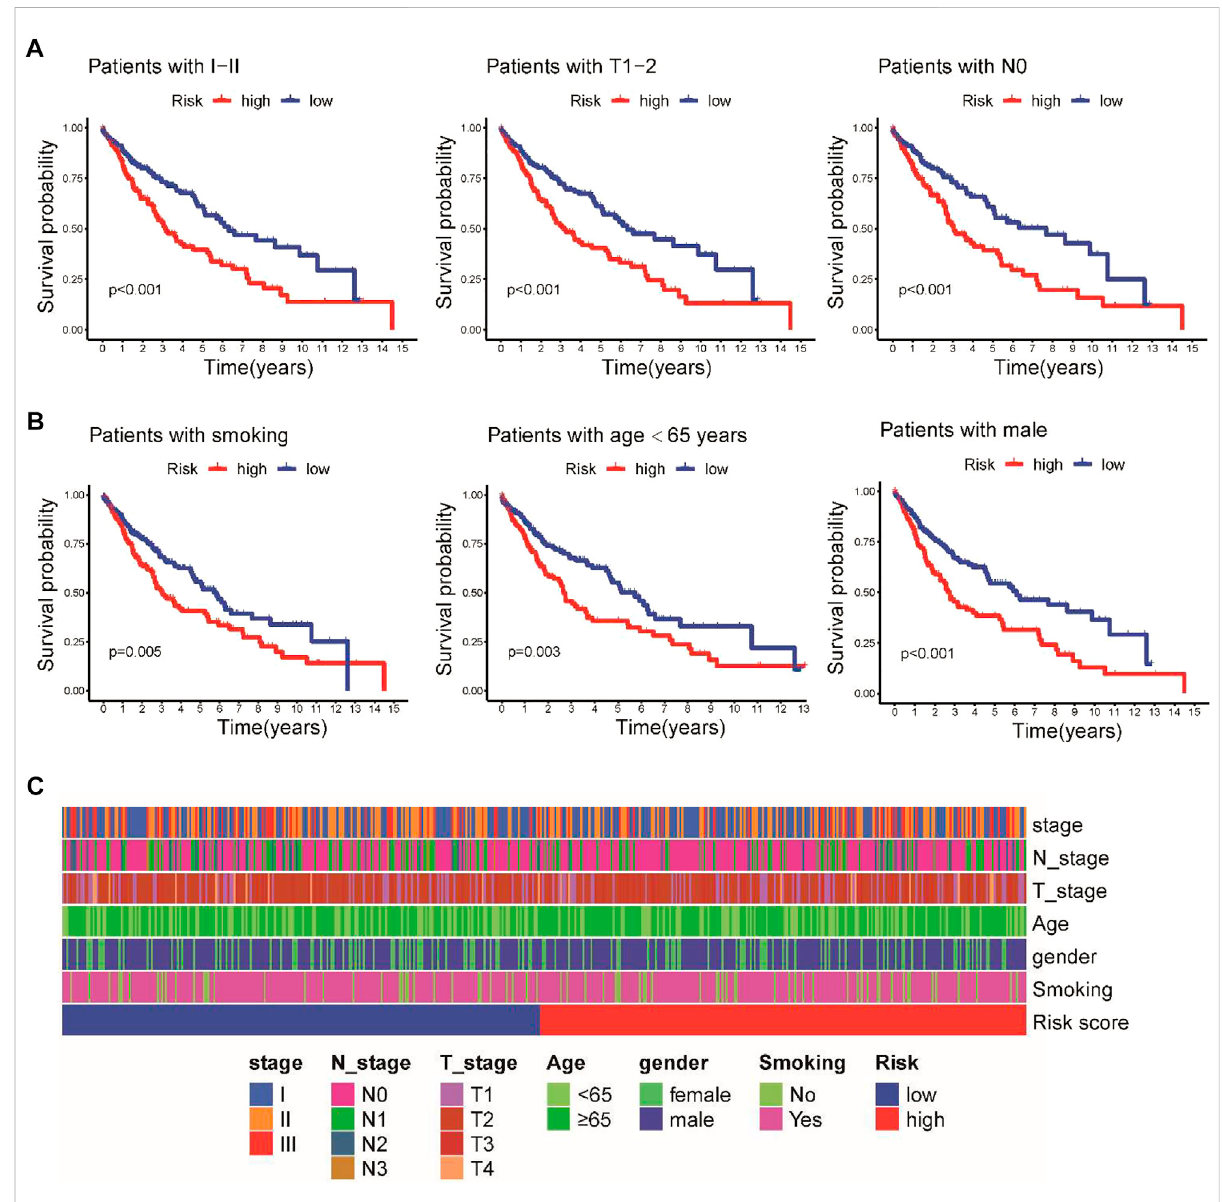
FIGURE 4 Strati fi edKaplan – Meiersurvivalanalysis ofdifferentclinicalsubgroupsintheTCGAcohort. (A) ClinicalI-IIstage,T1-2,andN0pathologicstage. (B) Smoking status, age, and sex. (C) Heatmap illustrating the associations between the risk score and clinicopathological